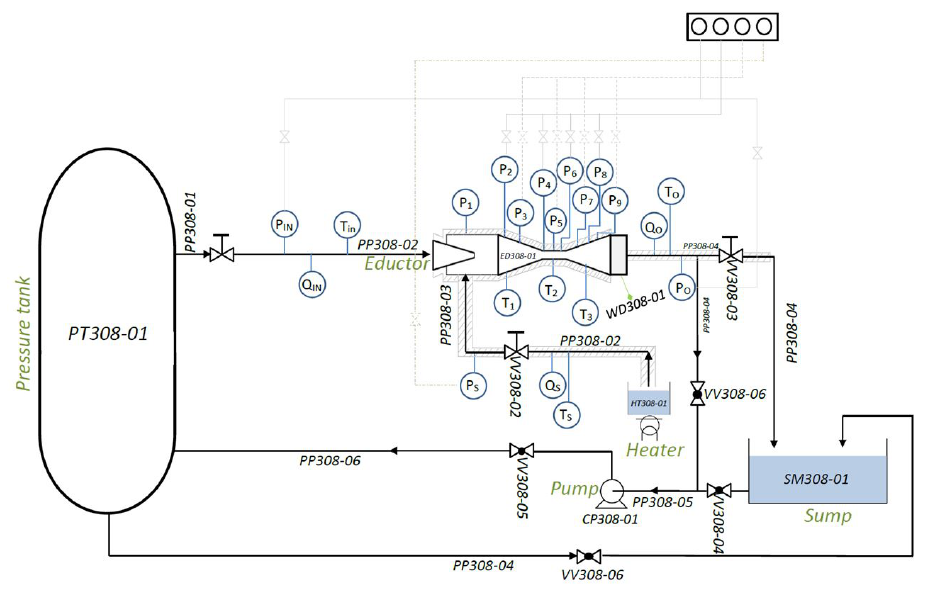
Figure 3. Schematic diagram of experimental setup. Table 1. Operational parameters of